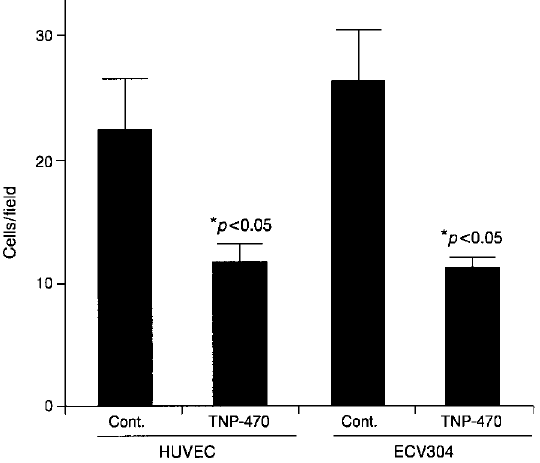
Fig. 4. The effects of conditioned medium from HT1080 treated with TNP-470 on endothelial migration. Motility of HUVEC and ECV304 cells suspended in the conditioned medium from HT1080 treated with or without TNP-470 (10 ng/ml) was determined by chemotaxis assays using a transwell cell culture chamber. Data are means from 3 independent experiments ±